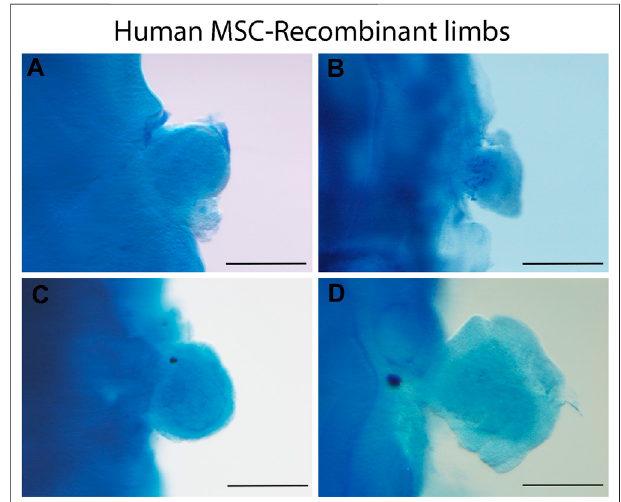
FIGURE 2 | Human MSC-derived RL from different sources. Alcian blue staining of 24 h recombinant limbs performed with human MSCs assembled in chicken ectoderms. MSCs were obtained from (A) bone marrow, (B) Wharton ’ s jelly, (C) umbilical cord blood, and (D) placenta. Chicken ectoderms and host embryos were obtained from the 22 HH stage. Scale bar 100